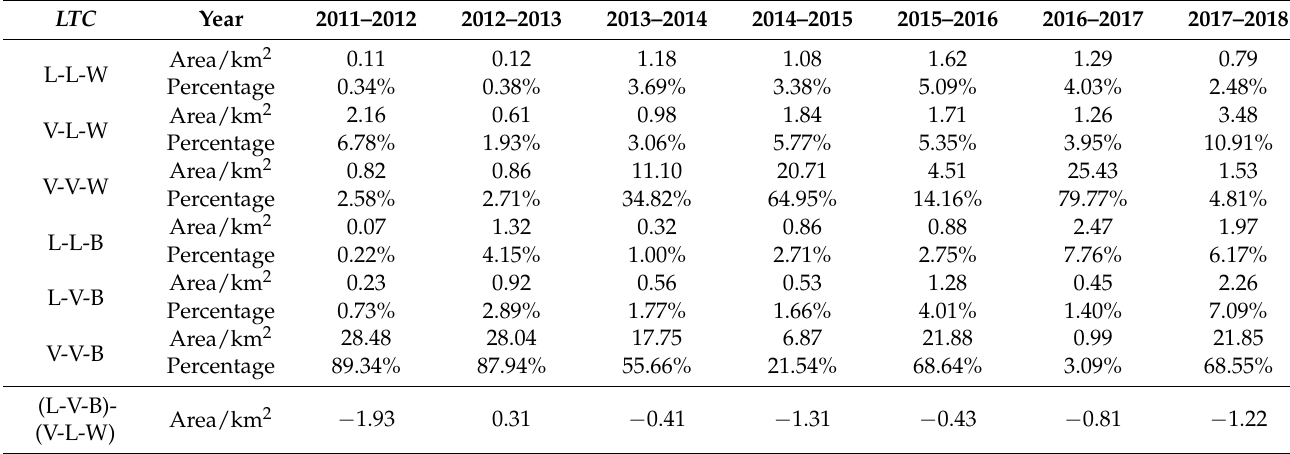
Table A2. Areas and percentages of different land type changes in two adjacent years from 2011 to 2018 in the study region. LTC